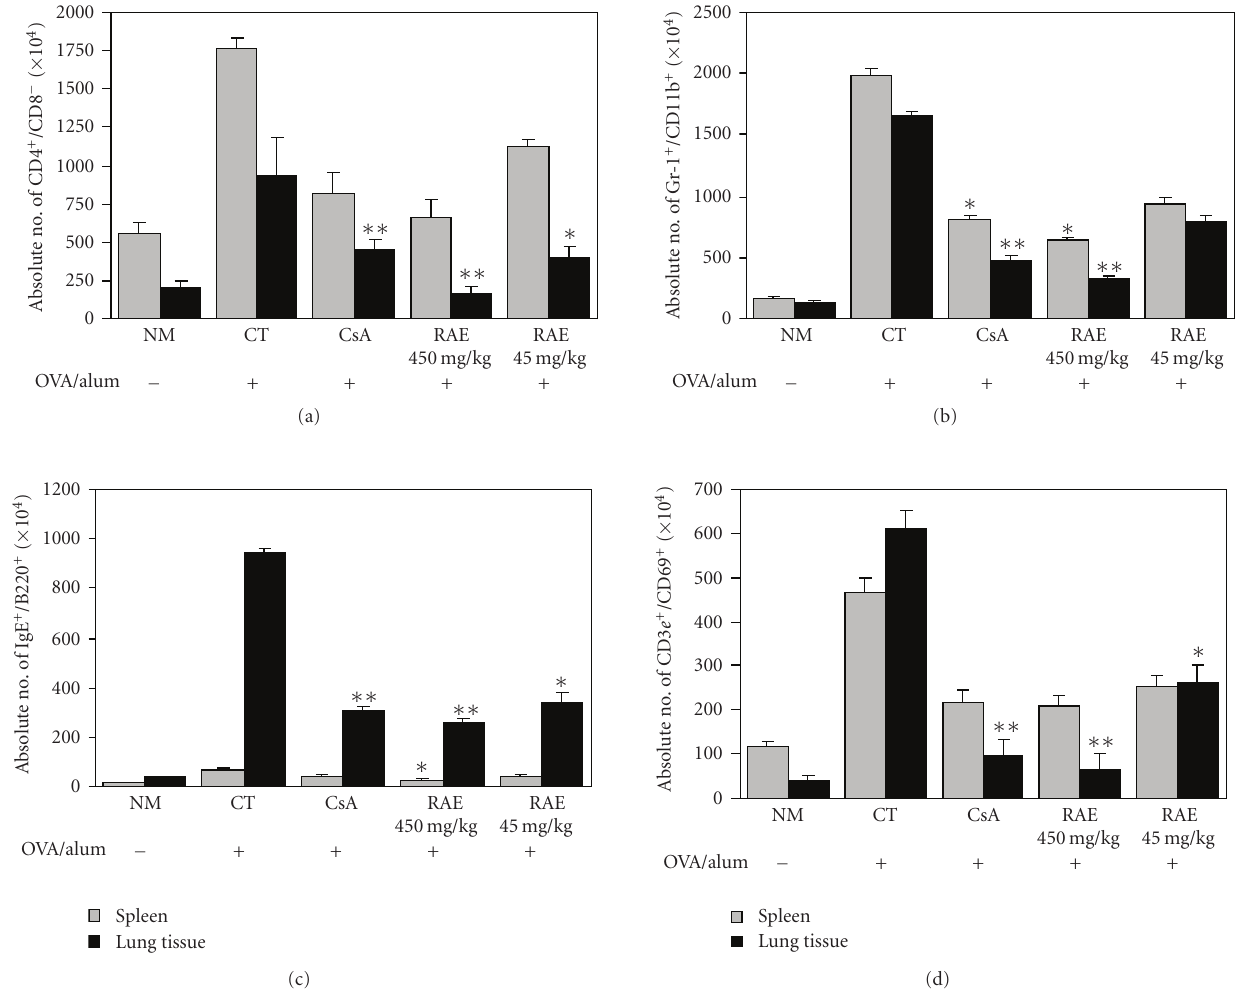
Figure 6: E ff ects of RAE on CD4 + /CD8 − , GR-1 + /CD11b + , IgE + /B220 + , and CD3e + /CD69 + cells absolute number in lung and spleen tissues of OVA-induced asthma murine (NM: normal C57BL/6 mice; CT: OVA-induced asthma mice (control); CsA: OVA-induced asthma mice treated with cyclosporine A (10mg/kg); RAE 450 mg/kg: OVA-induced asthma mice treated with RAE (450 mg/kg); RAE 45 mg/kg: OVA- induced asthma mice treated with RAE